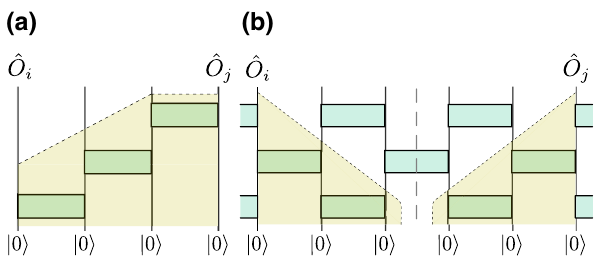
ˆ ˆ ˆ ˆ O i O i (cid:2)(cid:4) O j (cid:2) . (a) O j (cid:2) − (cid:4)